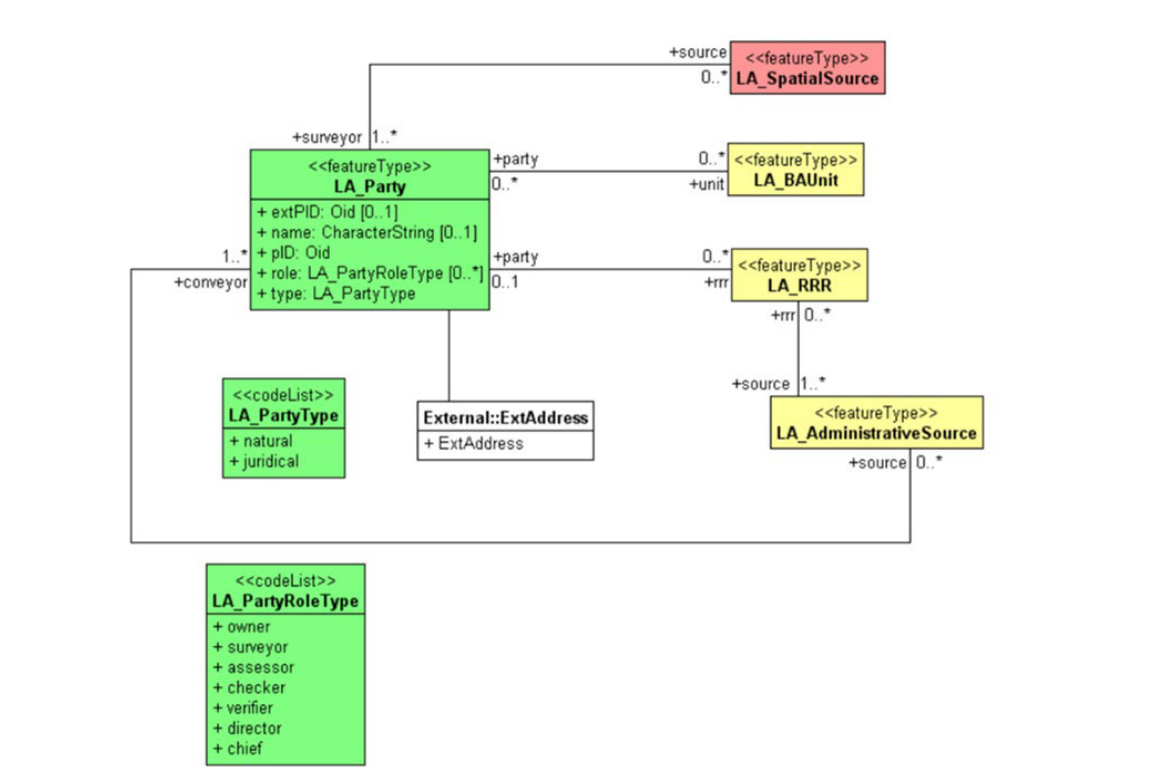
Figure 4 . Localized classes of the Party